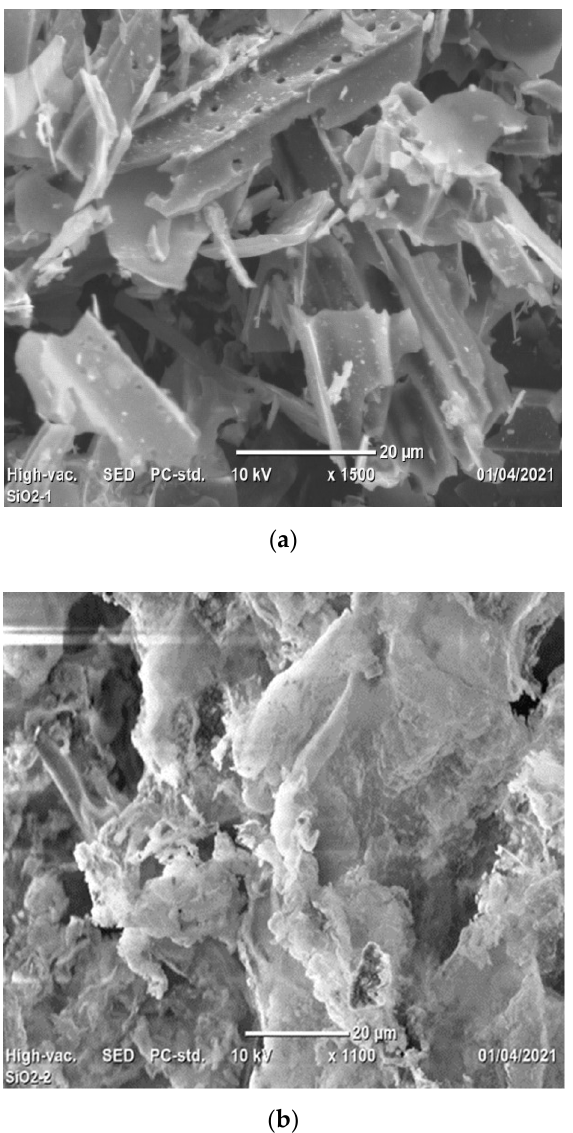
Figure 7. SEM images: ( a ) Controlled-burned (600 °C/2h) bagasse ash (HT–BA); ( b ) Uncontrolled- burned (300 °C/5min) bagasse ash (LT–BA).